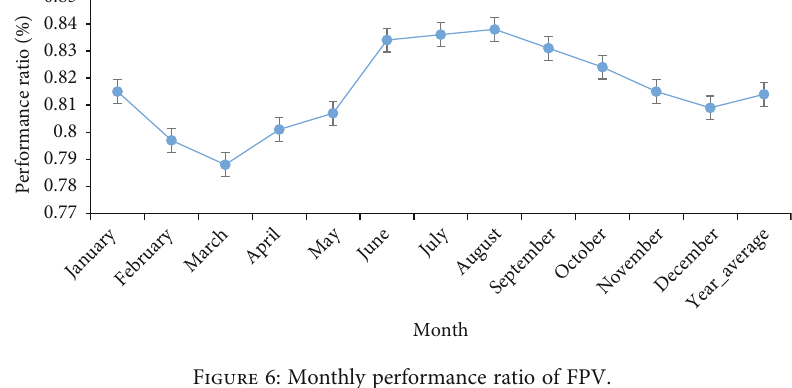
Figure 6: Monthly performance ratio of